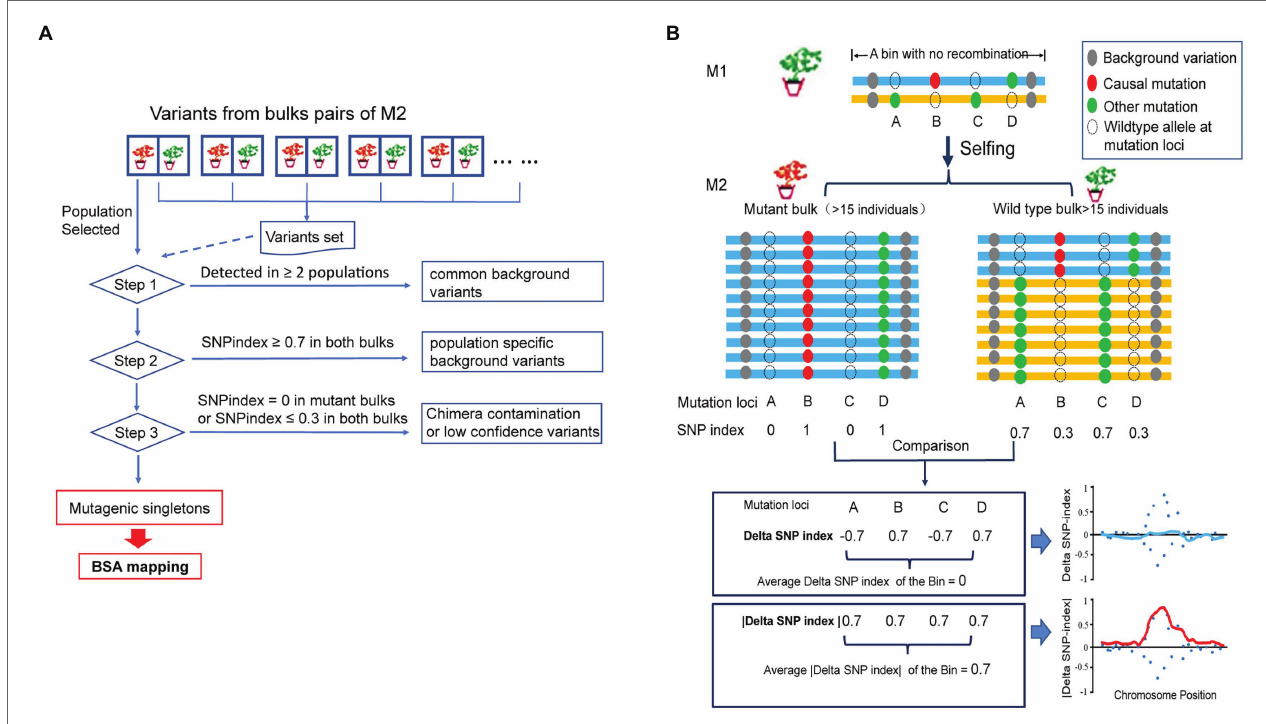
FIGURE 1 | A simplified scheme of M2-seq. (A) Overview of the process of variant filtering. (B) Mapping a genomic region harboring a causal variant. The curve of absolute value of delta single-nucleotide polymorphism (SNP) index (red curve) is used to identify the region of a causal mutation (for details, see